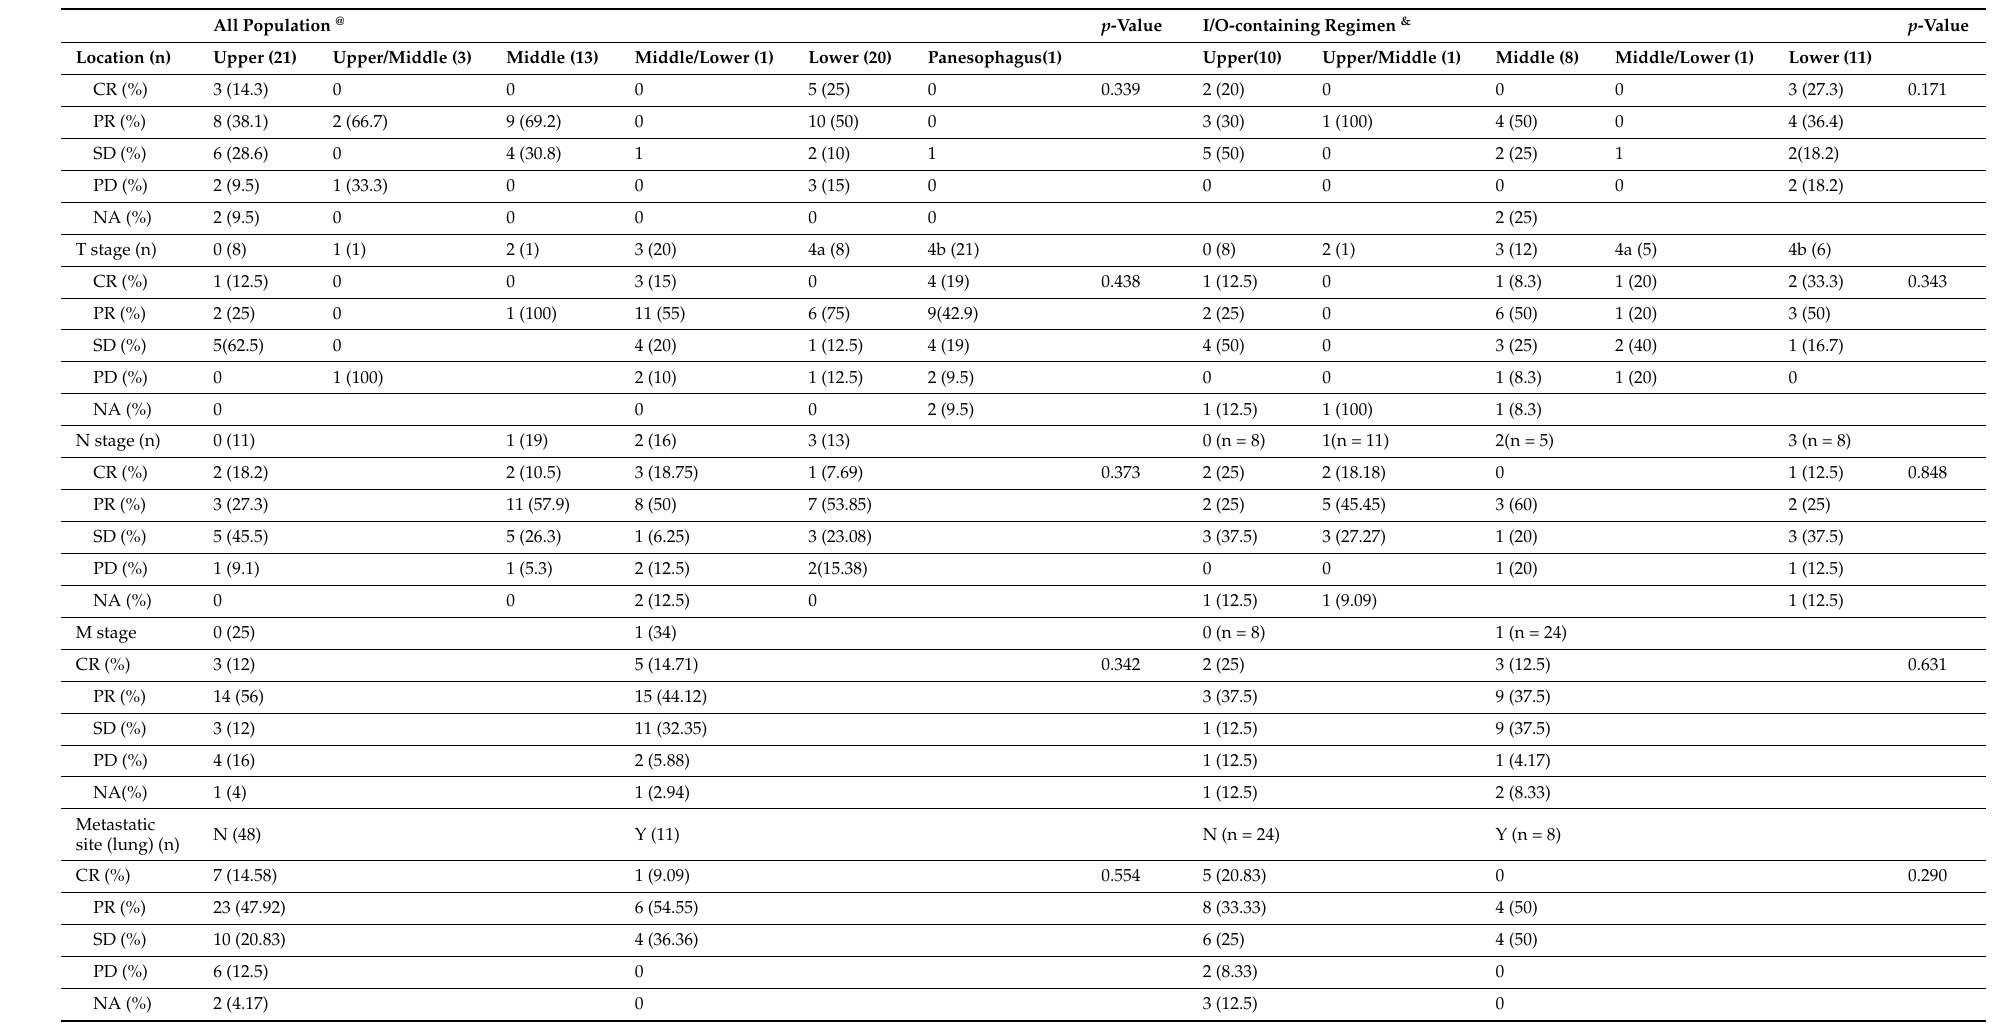
Table 3. Factors related to treatment